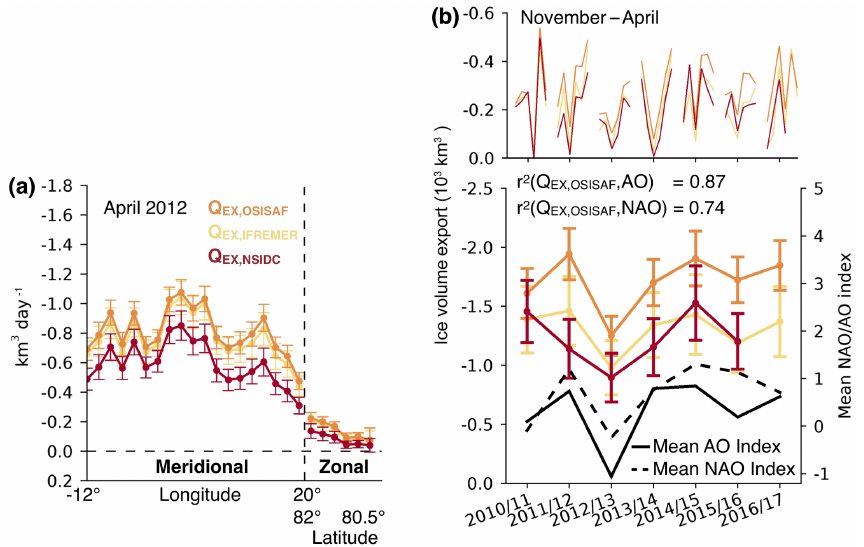
Figure 7. (a) Example for monthly ice volume export through the Fram Strait gate (April 2012) derived from three different ice drift products. (b) Monthly sea ice volume export (upper panel) and total Arctic sea ice volume export through the Fram Strait for winter seasons 2010– 2011 and 2016–2017, added together over the November–April period and derived from three different ice drift products (lower panel). Mean Arctic Oscillation (AO) Index and mean North Atlantic Oscillation Index (NAO) are shown for the same period, including coefficients of determination ( r 2